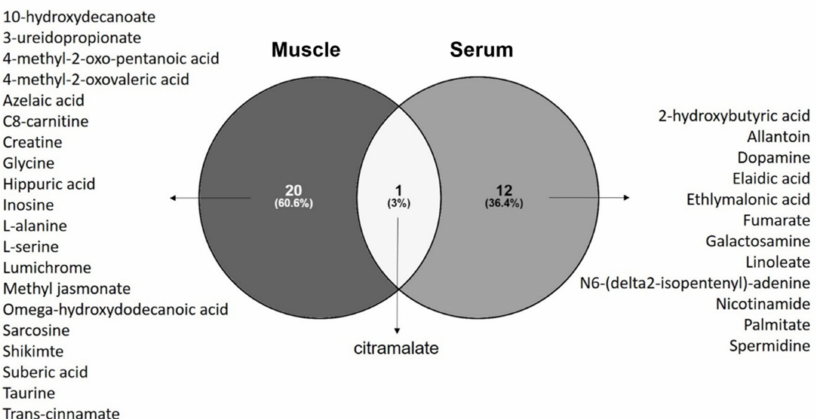
Figure 2. Venn diagram with discriminant metabolites revealed by univariate and univariate analysis identified 12 metabolites specific for serum of ALS patients, 20 metabolites specific to muscle of ALS patients, and citramalate as the metabolite commonly altered in serum and muscle of ALS patients when compared to control subjects. Venn diagram build with Venny 2.1.0 (https://bioinfogp.cnb.csic. es/tools/venny/index.html accessed on 15 April